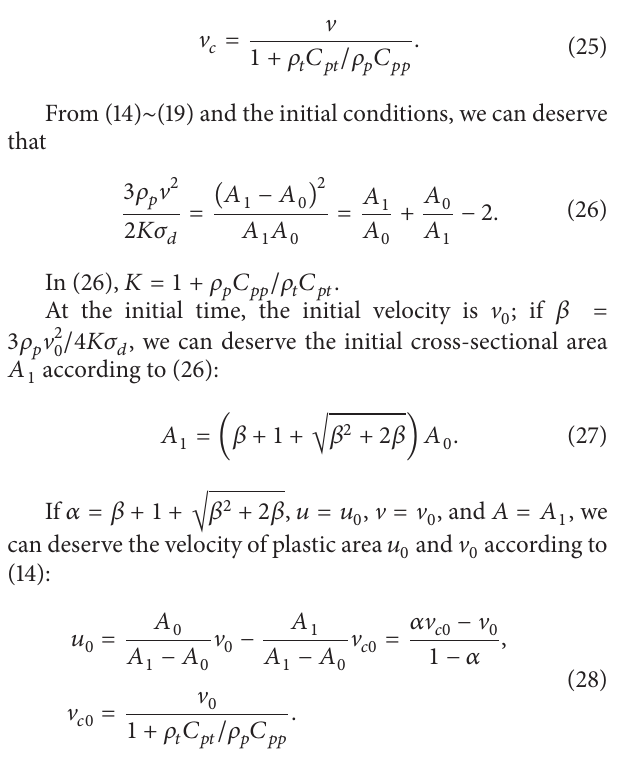
Table 5: Penetration depth of experiments and